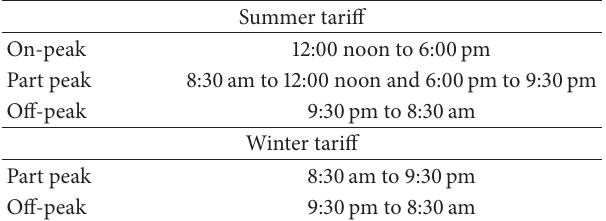
Table 1: TOU tariff periods.